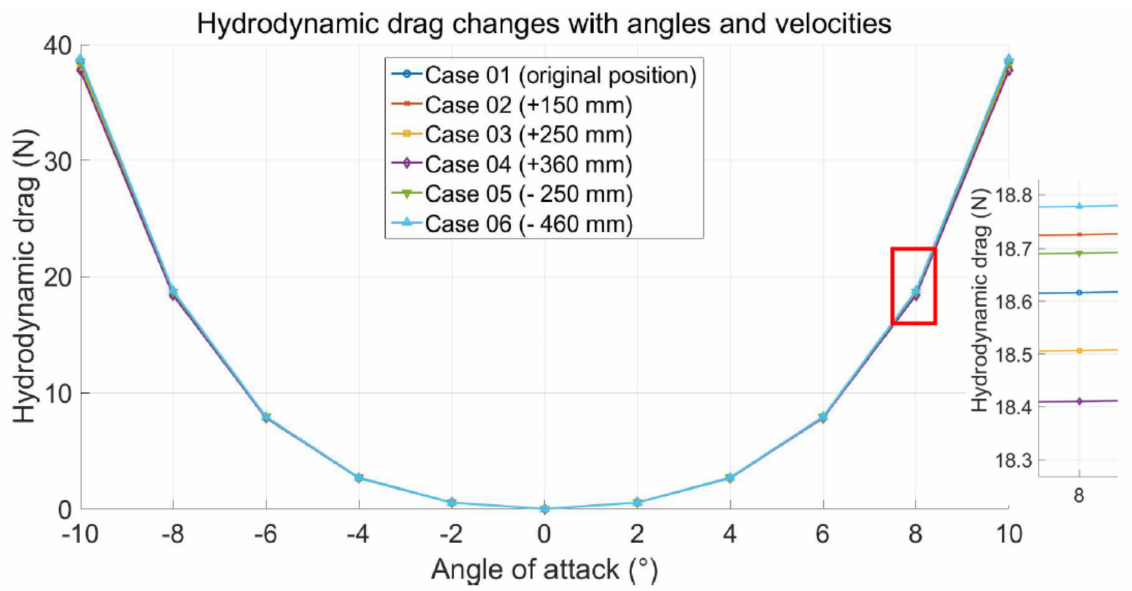
Figure 7. Variation in the hydrodynamic lift according to angles and velocities.